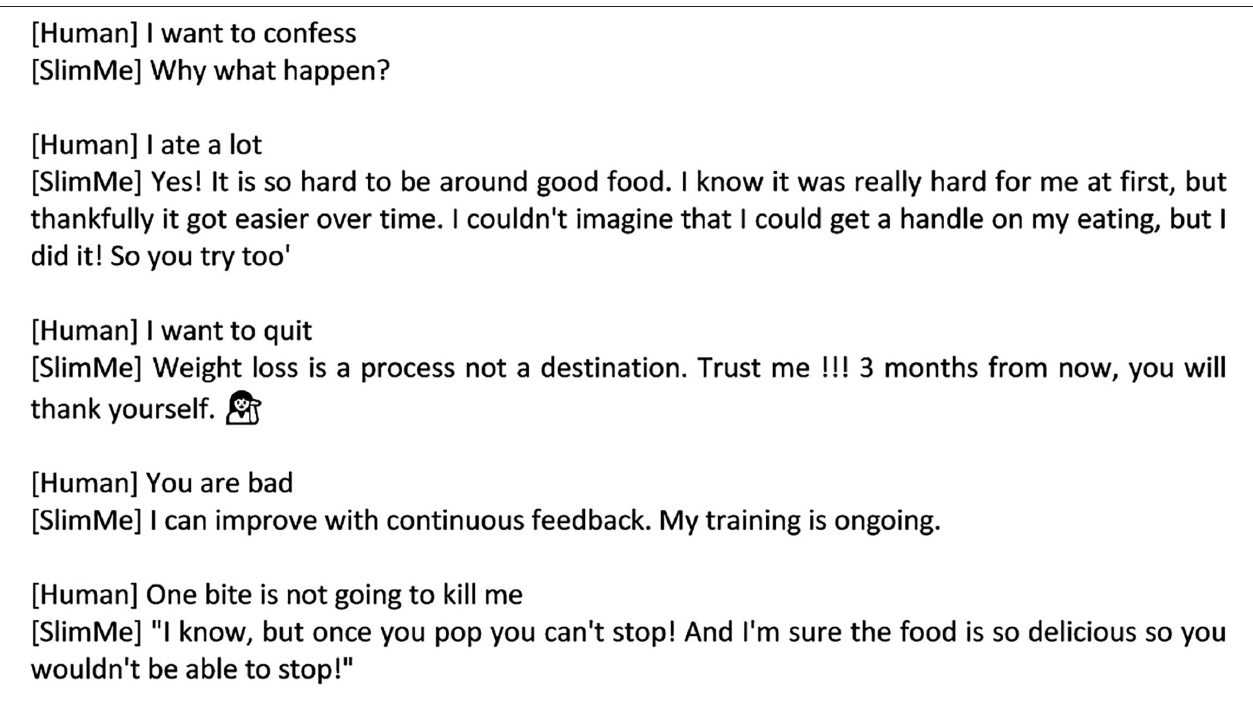
FIGURE 2 | Sequence conversation between SlimMe and users.